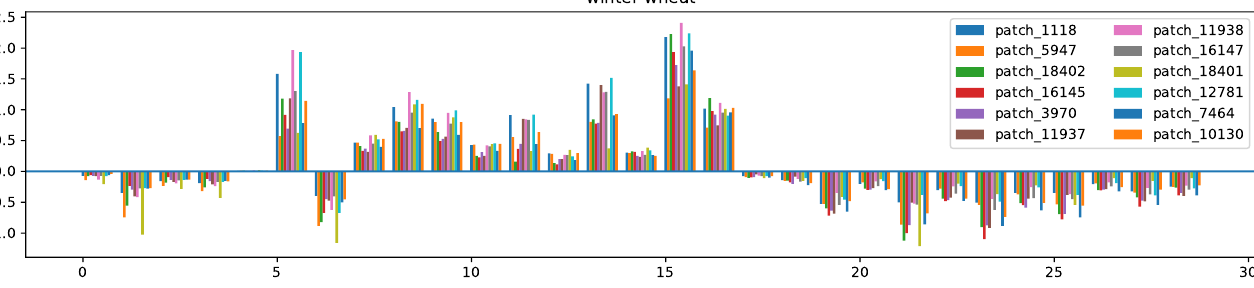
Figure 8. Mean CAIs calculated for all patches of the Munich test set that contain at least 100 pixels labeled with the winter wheat class. The CAI values for each patch were aggregated using the mean. The X axis reports the integer values from 1 up to the number of images used in the time series and therefore is a sampling of the time period analyzed on each series (one year in this paper). The Y axis represents the activation of the output predicted class (CAI) at the date it saw in the input time